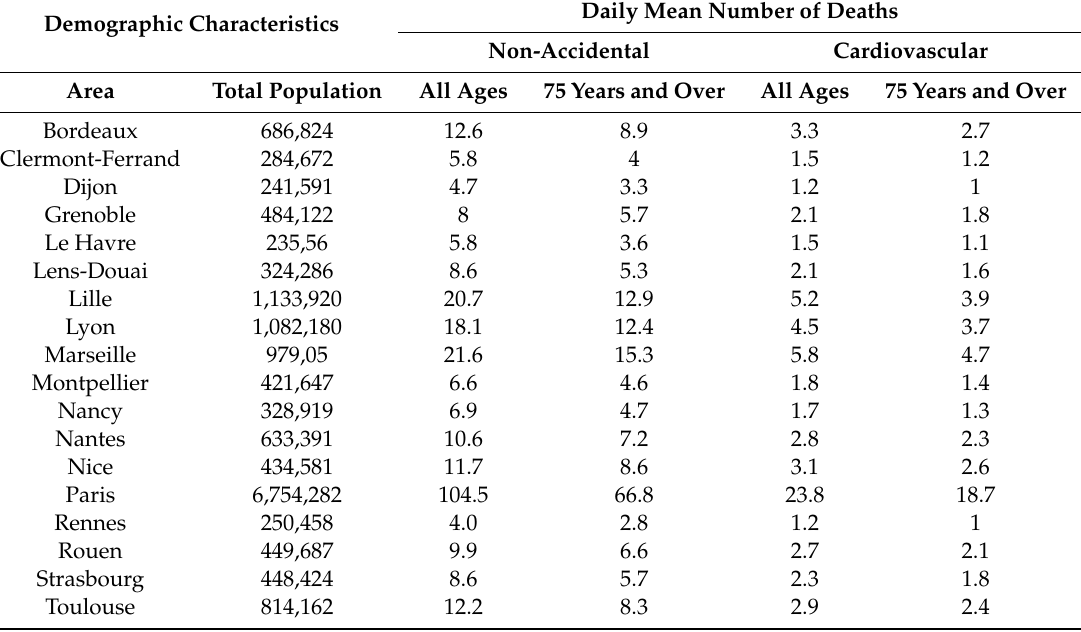
Table 2. Demographic characteristics and daily mean number of non-accidental and cardiovascular deaths for all ages and for people aged 75 years and over in 18 French areas: